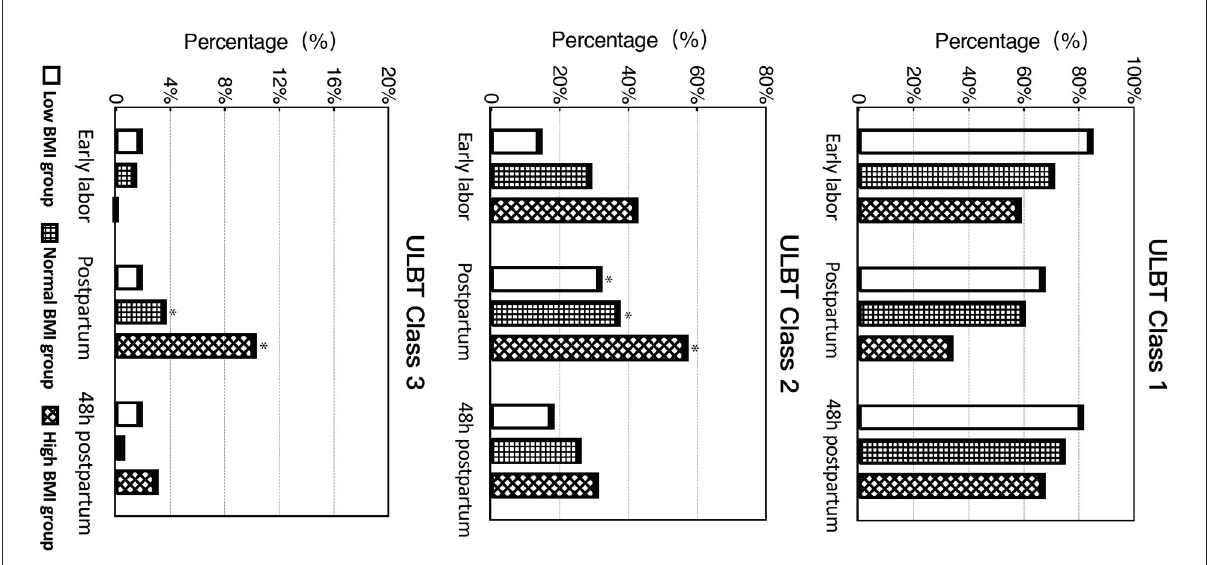
FIGURE2 Distribution of different ULBT classifications in early labor, postpartum and 48h postpartum. BMI, Body Mass Index; ULBT, upper lip bite test. *The proportion of ULBT level 2–3 increased significantly after delivery ( P < 0.001) and tended to return to the level in early labor 48h after delivery ( P = 0.074). *The incidence of increasing in ULBT grades after delivery in the high BMI group was statistically increase compared with the normal BMI group ( P =